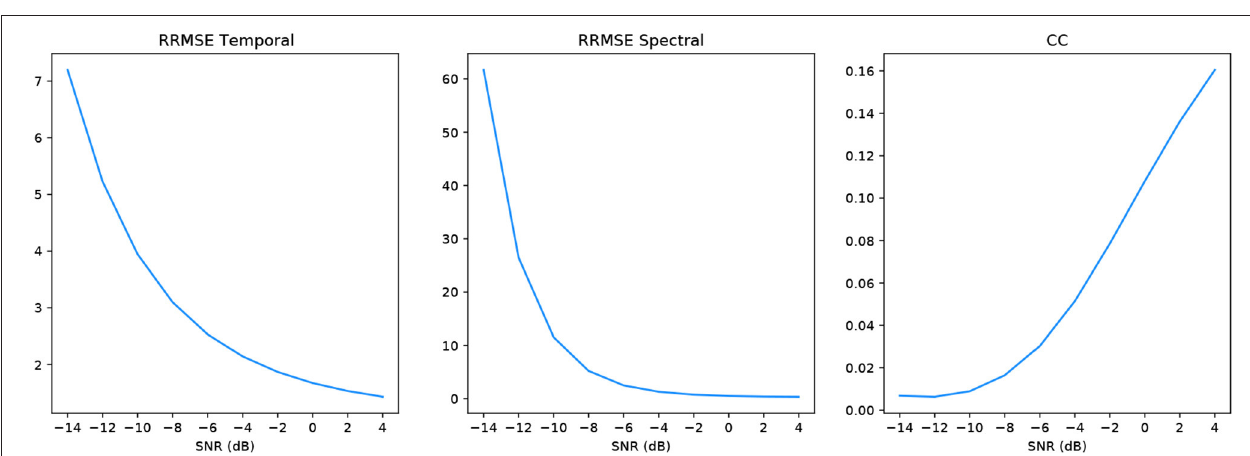
FIGURE 7 | Metrics of the EEG-EMG signals shown in Figure 5 (right).